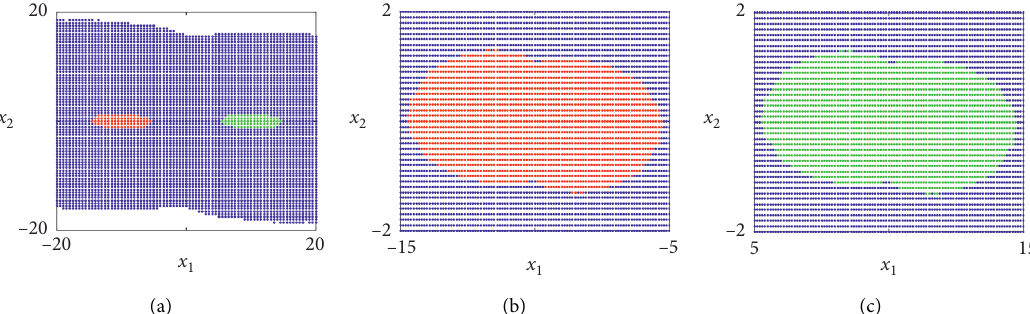
� 1 at x � 0. Red and green dots belong x 1 3